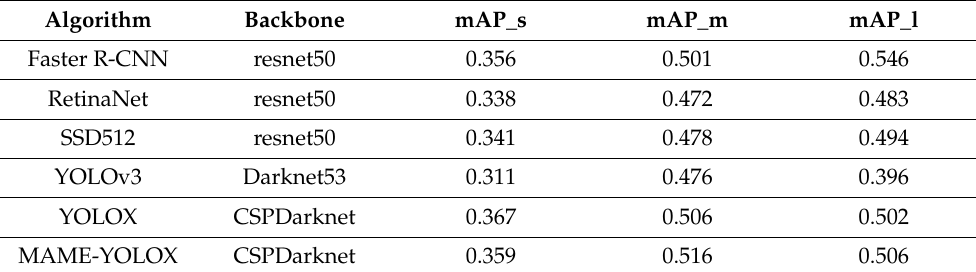
Table 3. Comparative experimental results of different algorithms on the AIBD